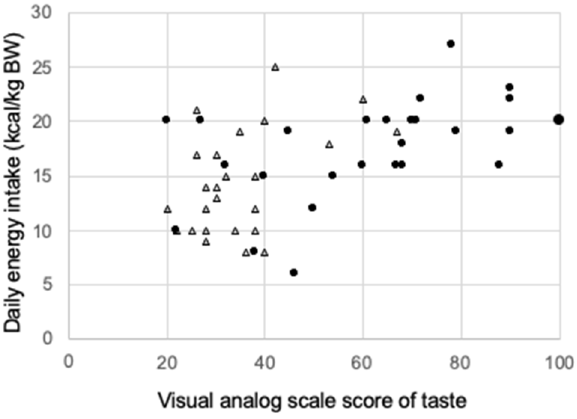
Figure 5. Correlation between daily energy intake and the visual analog scale (VAS) score of taste sensitivity after the second dose of chemotherapy in patients with head and neck cancer upon monosodium glutamate (MSG) dietary supplementation. Opened triangle; non intervention group, Closed circled; intervention group.